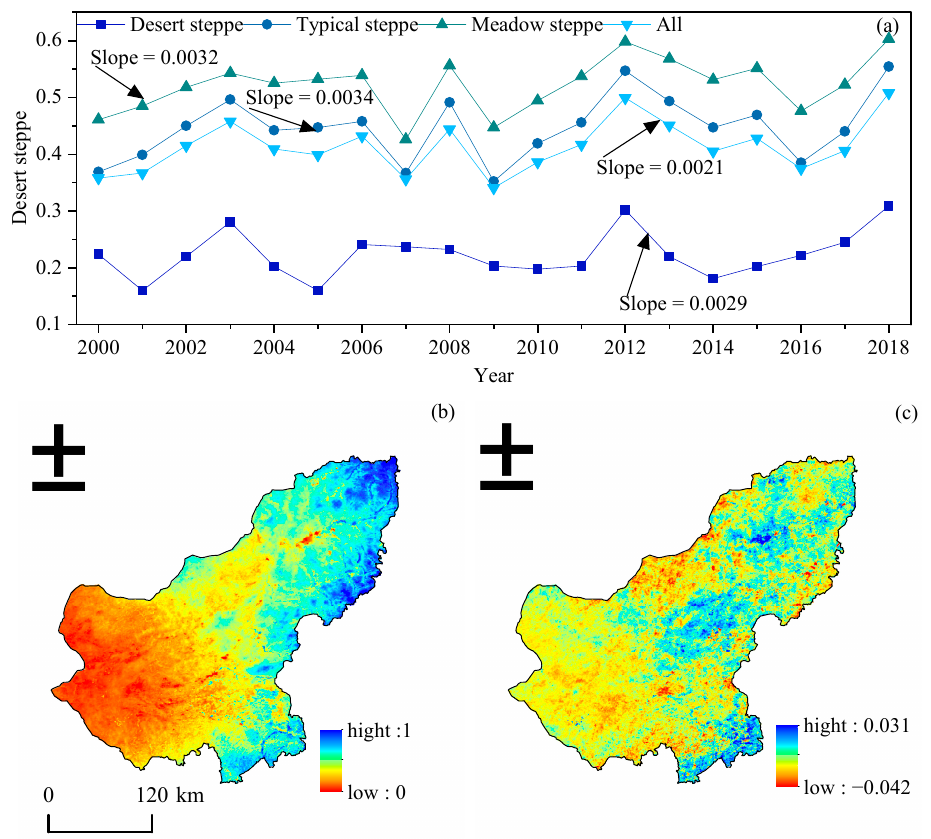
Figure 8. Changes in Xilin Gol’s NDVI in space and time from 2000 to 2018: ( a ) the trend of NDVI change between years in different types of grasslands, ( b ) the spatial distribution pattern of annual NDVI, and ( c ) the spatial distribution pattern of the rate of NDVI change.